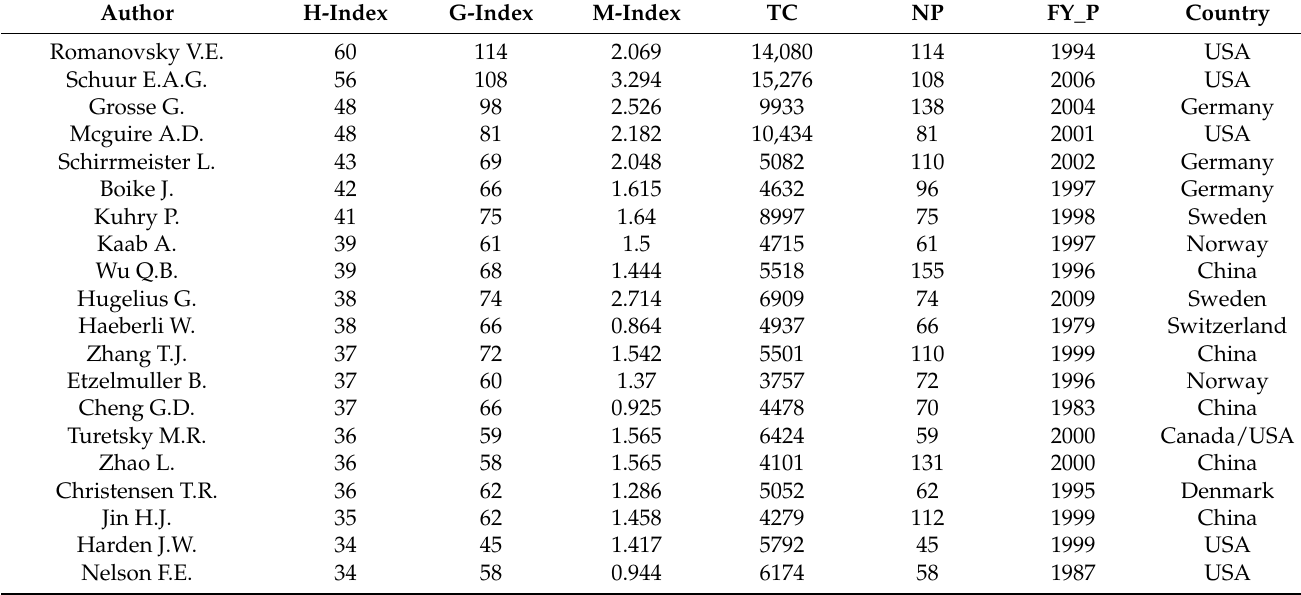
Table 4. The top 20 core authors on permafrost research ranked by